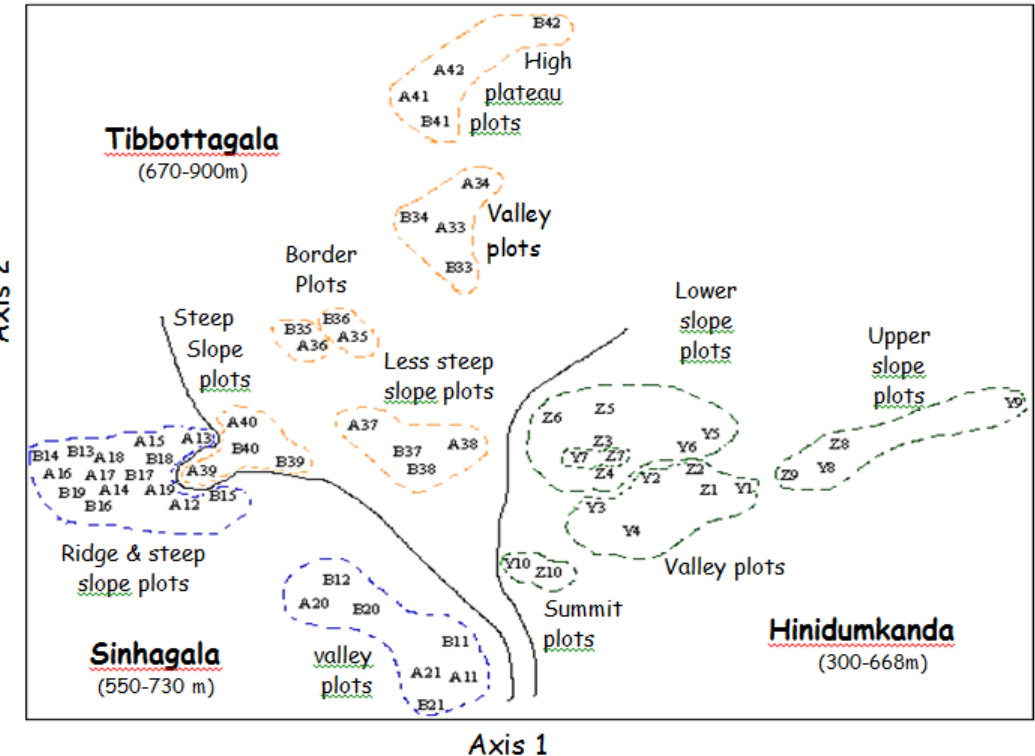
Figure 6: Ordination analyses of the distribution of plots sampled in three forests sites exhibiting landscape and local level floristic heterogeneity in hill forests at Hinidumkanda, Sinhagala and Thibbottagala respectively in southwest Sri Lanka (from Gunatilleke et al .